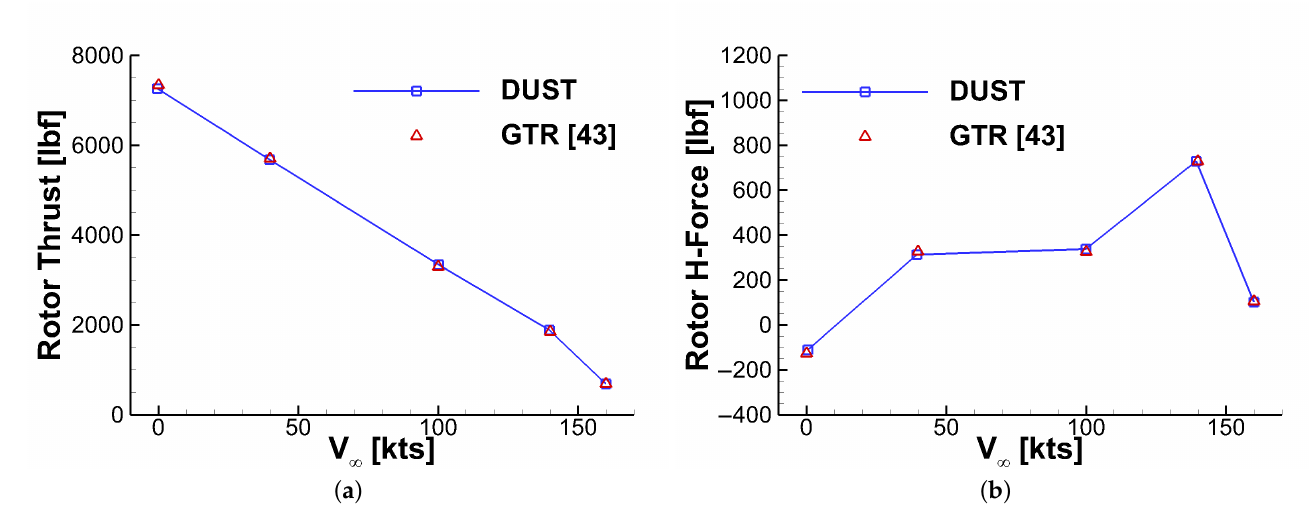
Figure 6. Trim targets for the proprotor thrust and H-force provided by Generic Tiltrotor (GTR) [46] compared with the results from the trimmed DUST simulations for all the flight conditions